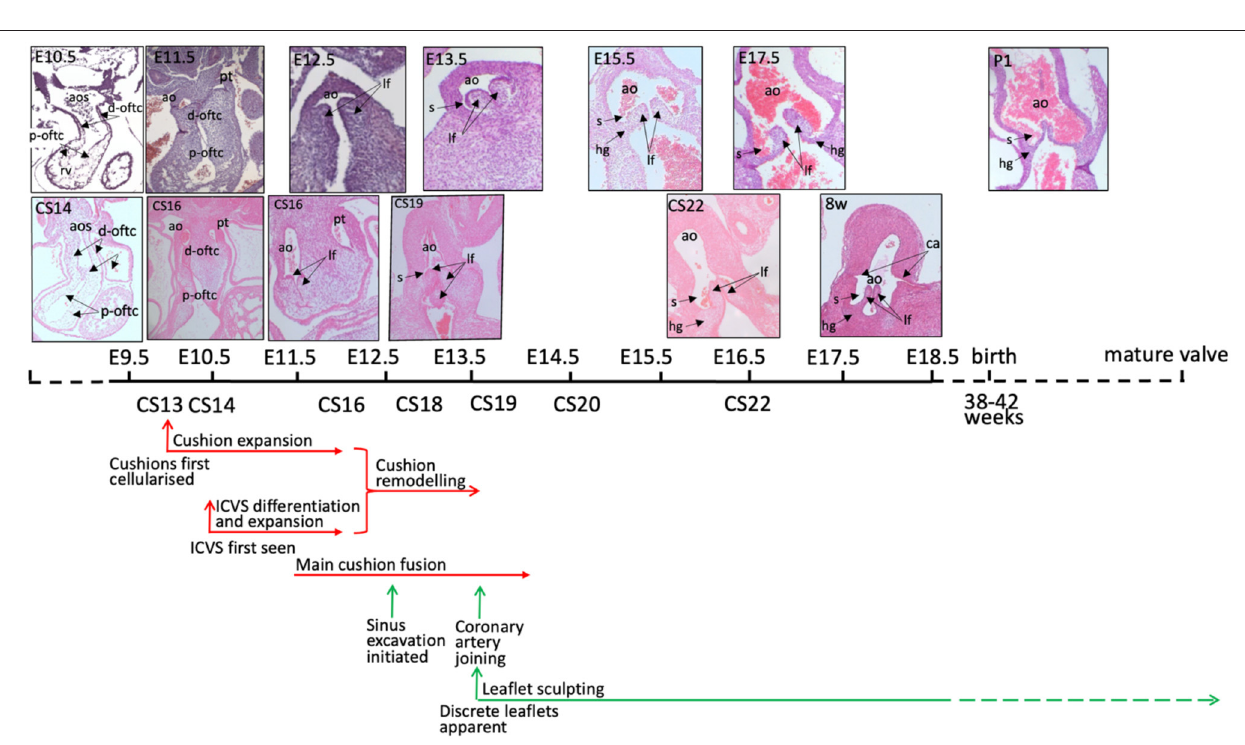
FIGURE 2 | Timeline of mouse and human aortic valve development. Mouse and human outflow cushions and valves (stained with haematoxylin and eosin) are anatomically similar and follow a similar pattern of development. There is some variation between similarly Carnegie-staged human embryos such that, for example, CS16 embryos can be matched to mouse hearts at both E11.5 and E12.5. At 8 post-conception weeks of gestation, the human heart is similar to a mouse embryo shortly before birth, although it is still the first trimester. The human histology images were provided by the Joint MRC / Wellcome Trust (MR/R006237/1) Human Developmental Biology Resource (www.hdbr.org) (6). Mouse embryos were obtained from mice maintained according to the Animals (Scientific Procedures) Act 1986, United Kingdom, under project licence PPL 30/3876. All experiments were approved by the Newcastle University Ethical Review Panel. ao, aorta; aos, aortic sac; ca, coronary artery orifice; d-oftc, distal outflow tract cushions; hg, hinge; lf, leaflet; p-oftc, proximal outflow tract cushions; pt, pulmonary